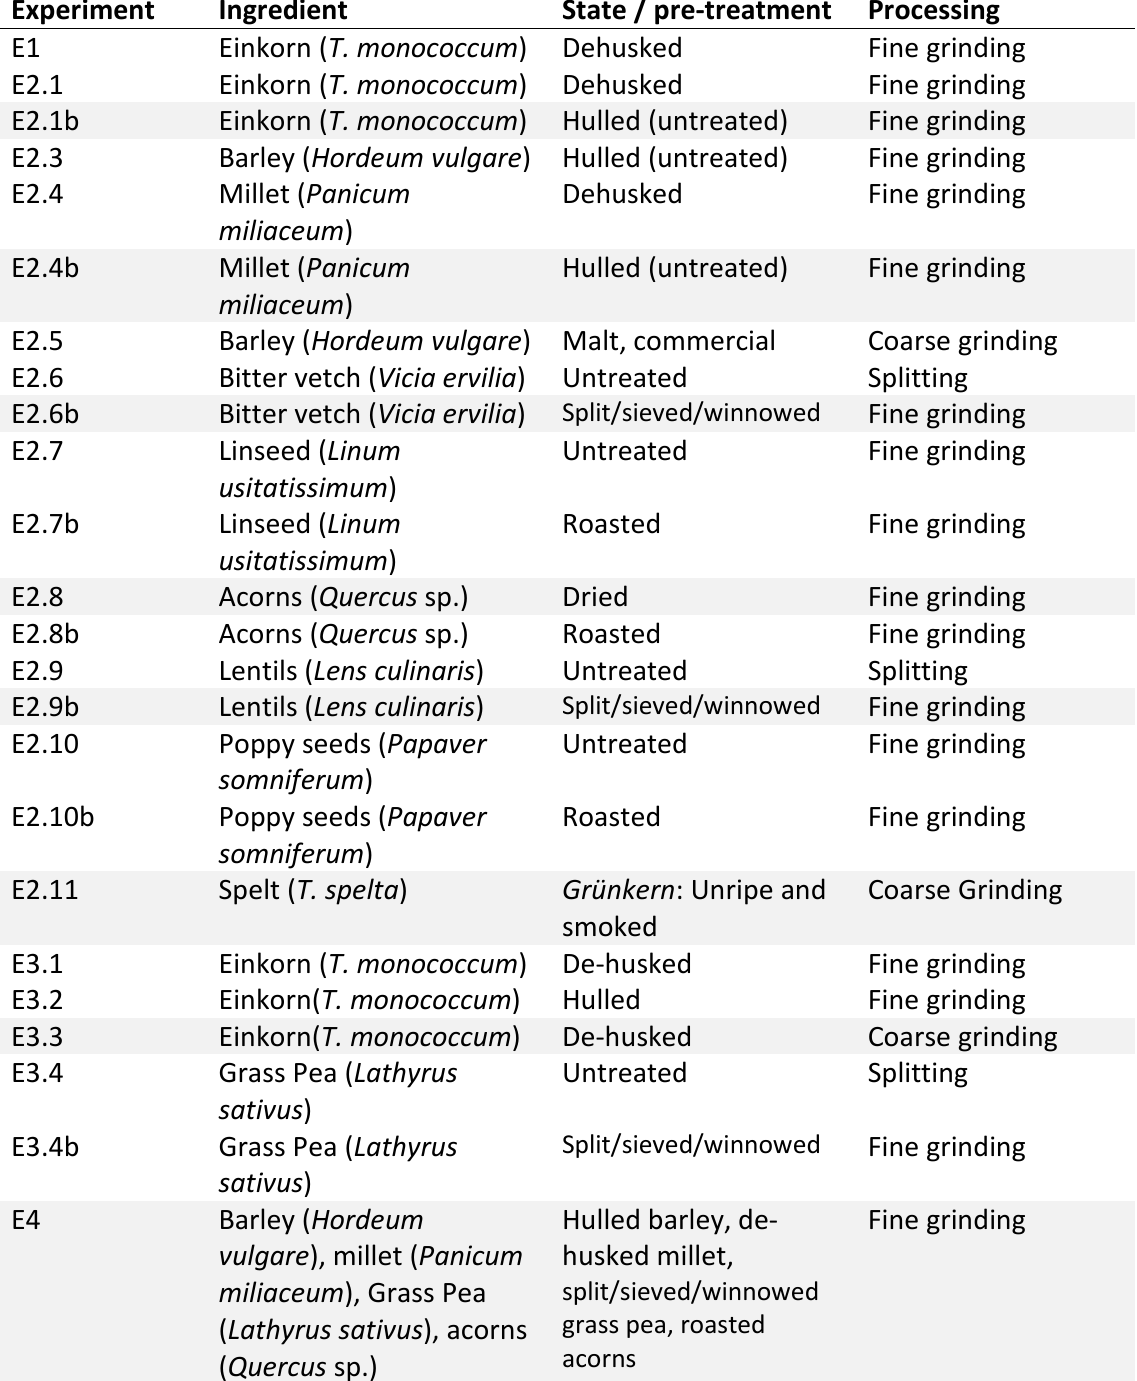
Table 2. List of plant ingredients used in the